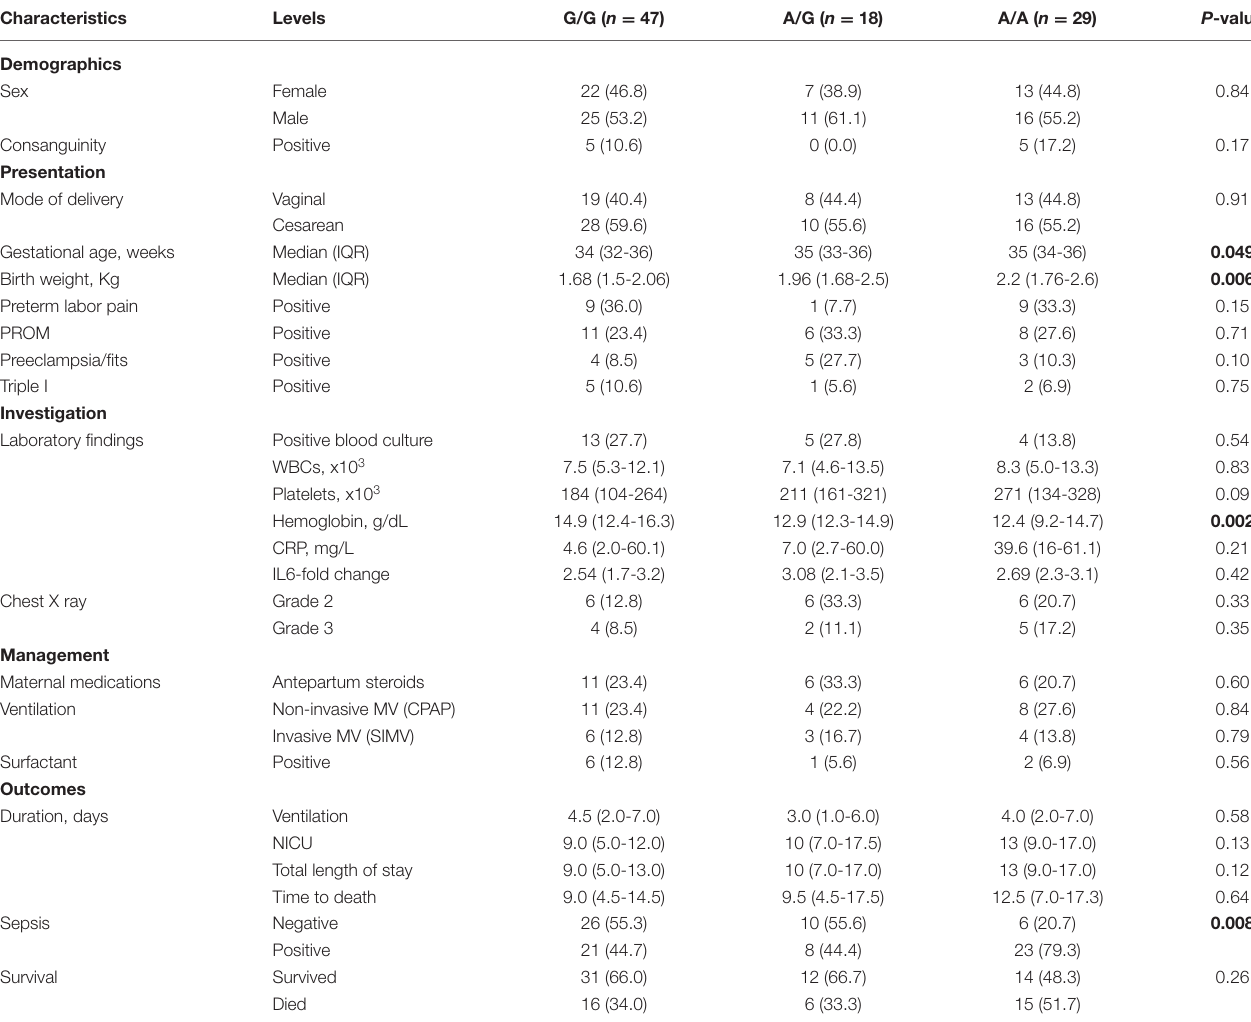
TABLE 4 | Association of C1INH polymorphism with clinical and laboratory characteristics of neonatal lung disease cohort. Characteristics